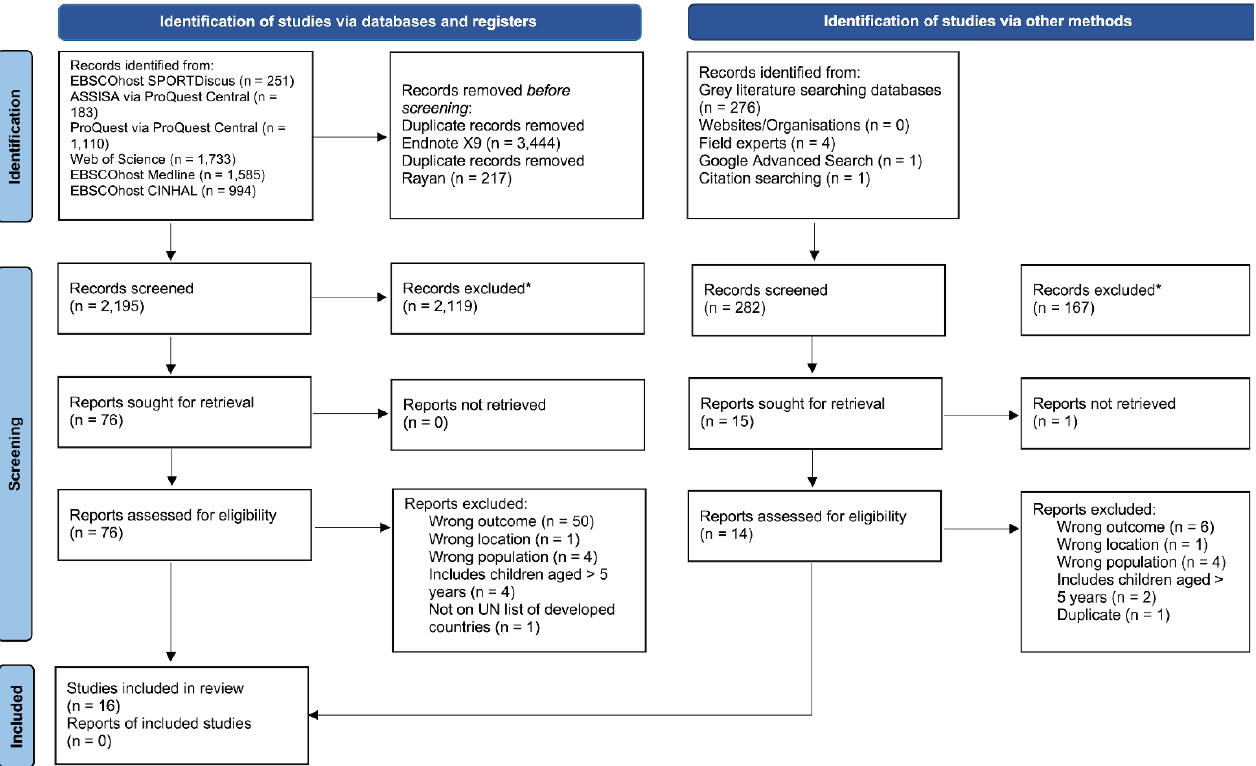
Figure 1. PRISMA 2020 flow diagram for new systematic reviews which included searches of databases, registers, and other sources. Note: * Automation tools were not used; n = number; UN = United Nation.